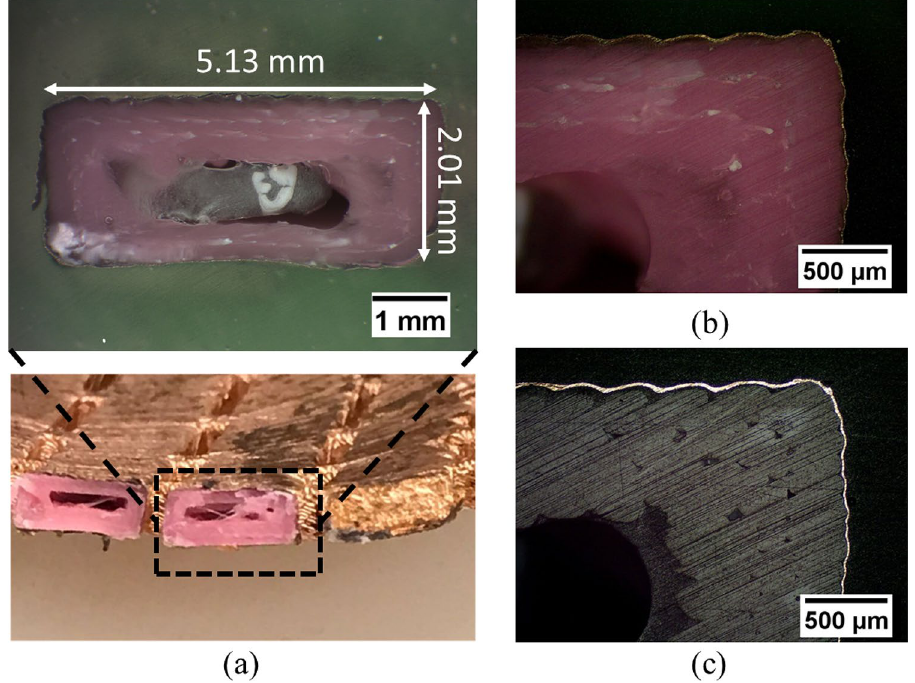
Figure. 7. (a) Cross-sectional area of the FSS after copper plating, (b) zoomed view under microscope, and (c) high contrast view to illuminate the metallization layer.